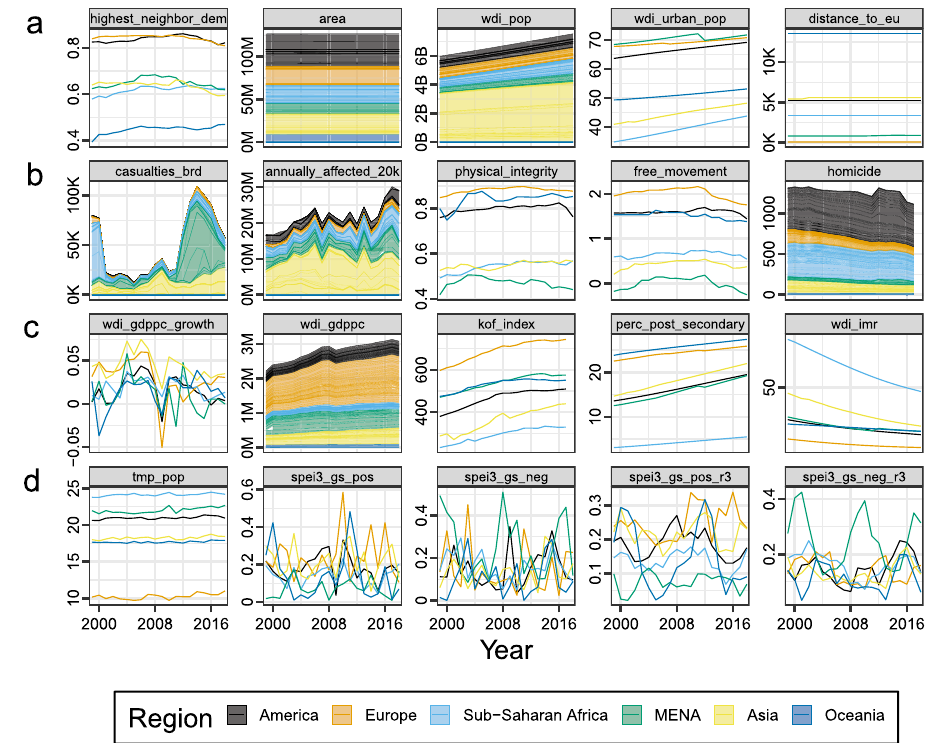
Fig. 2 Spatiotemporal patterns in drivers of asylum migration, aggregated by region. a Baseline component: highest democracy score in neighborhood (average score); country area (cumulative km 2 ); country population (cumulative); urbanization rate (average %); distance to nearest EU member state (average km). b Violence component: battle-related deaths (cumulative); population size within 20 km of nearest con fl ict event (cumulative); physical integrity index (average score); freedom of movement (average score); number of homicides (cumulative). c Economy component: annual growth in GDP per capita (average rate); GDP per capita (cumulative Int$); interpersonal globalization index (average score); share of population with post-secondary education (average %); infant mortality rate (average). d Climate component: population-weighted mean temperature (average °C); positive deviation in growing-season-weighted SPEI-3 index (average σ ); negative deviation in growing-season-weighted SPEI-3 index (average σ ); positive deviation in 3-year moving average SPEI-3 (average σ ); negative deviation in 3-year moving average SPEI-3 (average σ ). MENA is the Middle East and North Africa. N = 3413 country-year